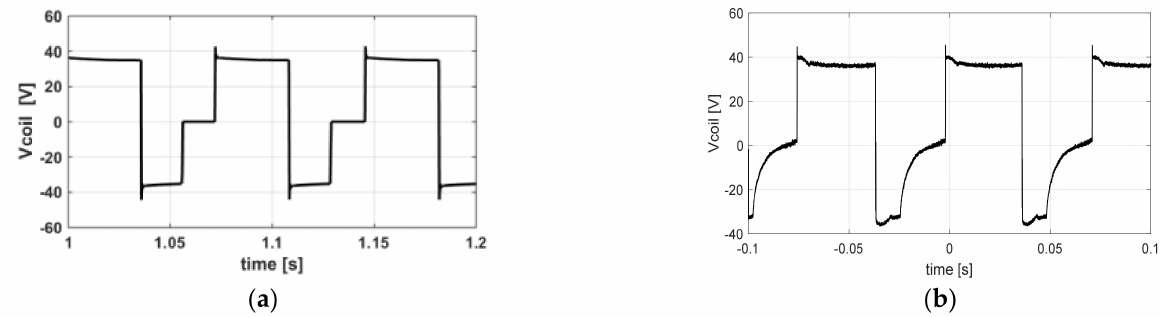
Figure 19. The waveforms of voltage across the coil (V coil ) at the no-load condition: ( a ) simulation results; ( b ) test